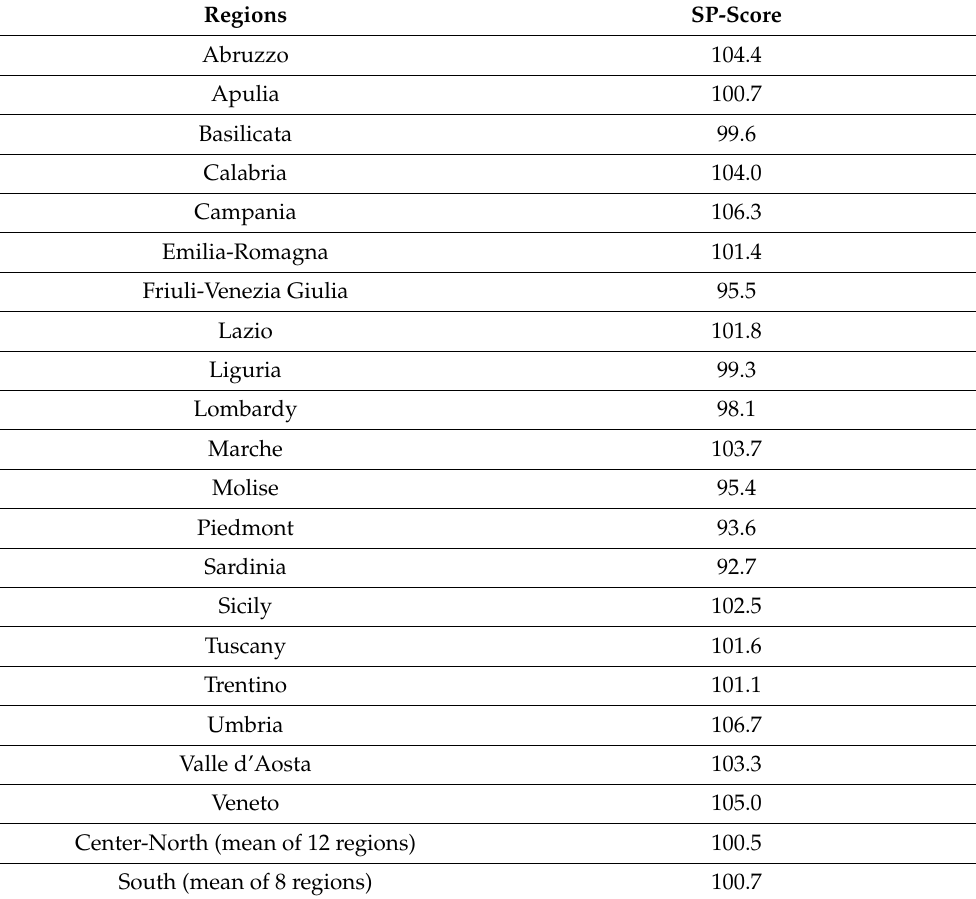
Table 6. SP-score for Italian NUTS2 regions—Innovative start-ups. MPI+